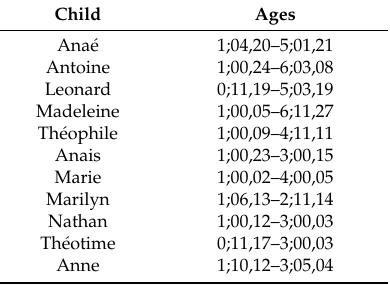
Table 1. Age Ranges of